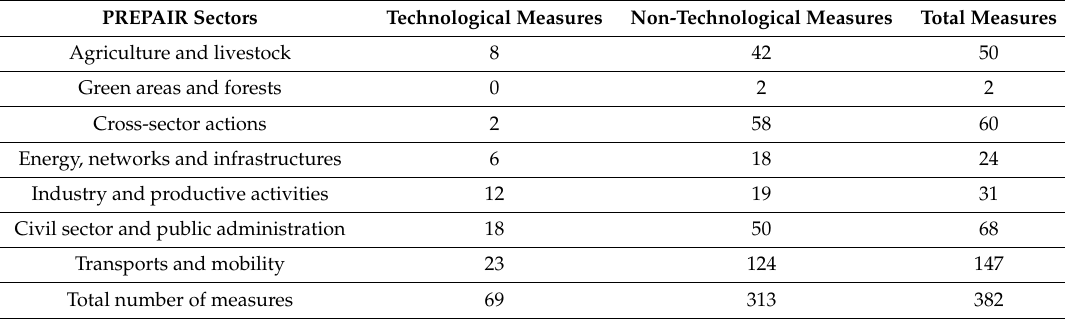
Table 2. Catalogue of Measures, technological / non-technological measures.